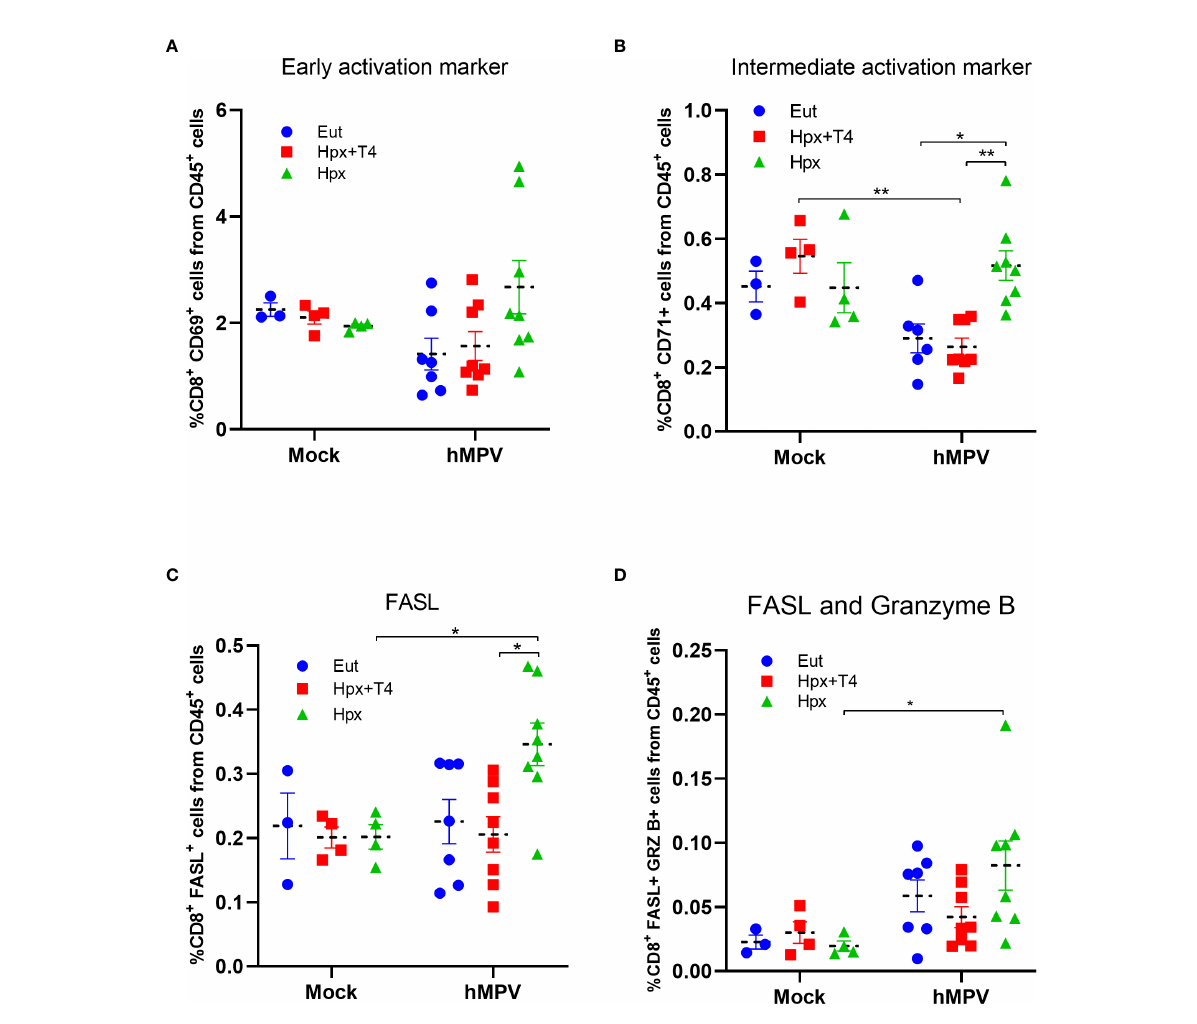
FIGURE 3 Female Hpx offspring present a high proportion of activated CD8+ T cells. Flow cytometry of single-cell suspension of CD8 + T cells on CD45 + cells from lung seven days post-infection with 1x10 6 PFU hMPV or mock for each animal group. Percentage of cells expressing the activation markers CD69 + (A) , CD71 + (B) , FASL + (C) and FASL + GRZB + (D) were analyzed in female mice from Eut, Hpx+T4 and Hpx mice. *p < 0.05; **p < 0.01 by two-way ANOVA and Sidak ’ s multiple comparisons test. Data are shown as the mean ± SEM of at least fi ve animals per group. SEM, standard error of the